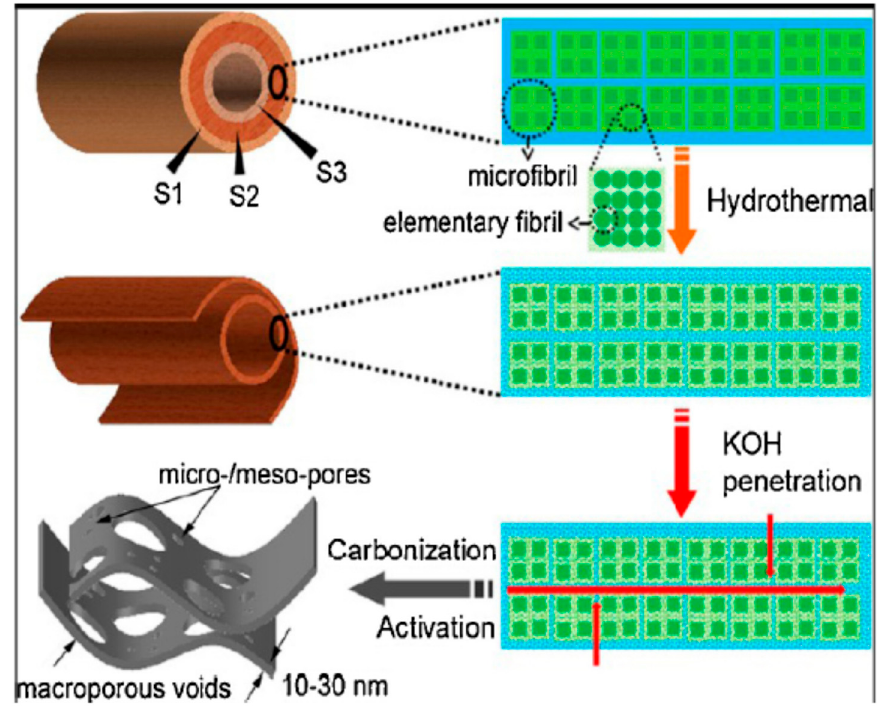
Figure 4. Preparation of graphene from Hemp fiber Reprinted with permission from ref. [39] Copyright 2013 American Chemical Society.